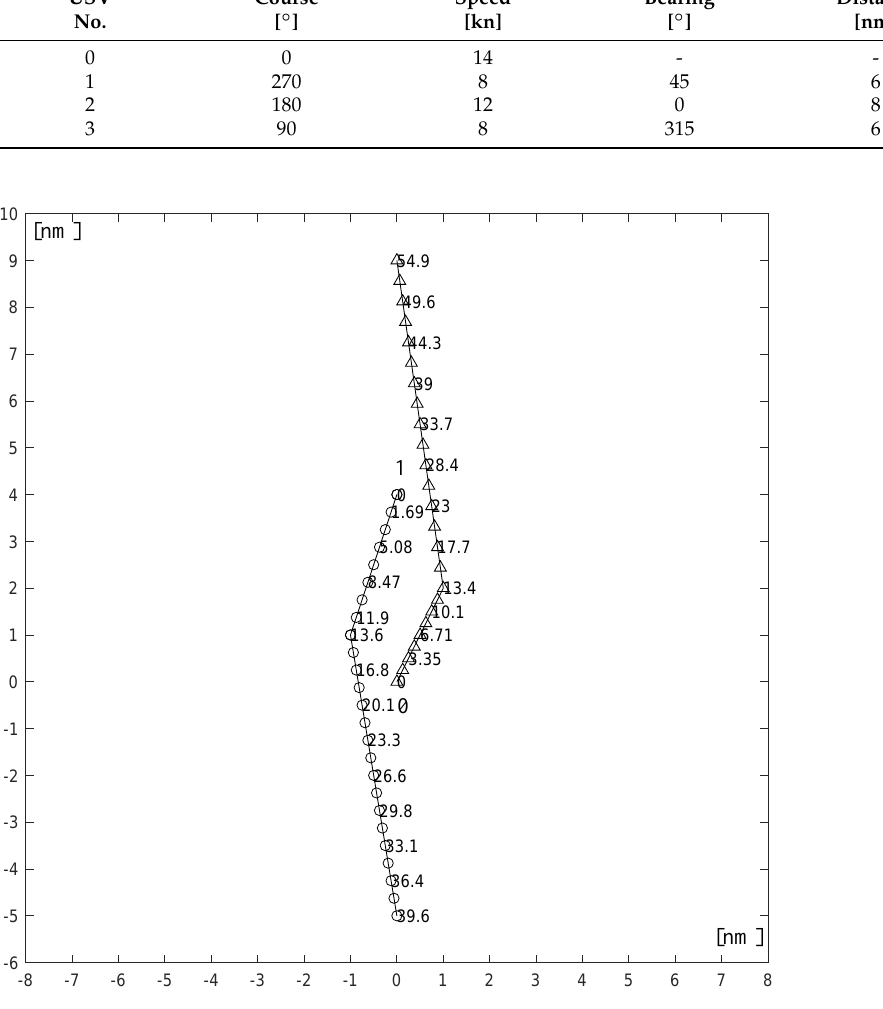
Figure 6. Solution of test case 1. Table 10. Output data of test case 1.